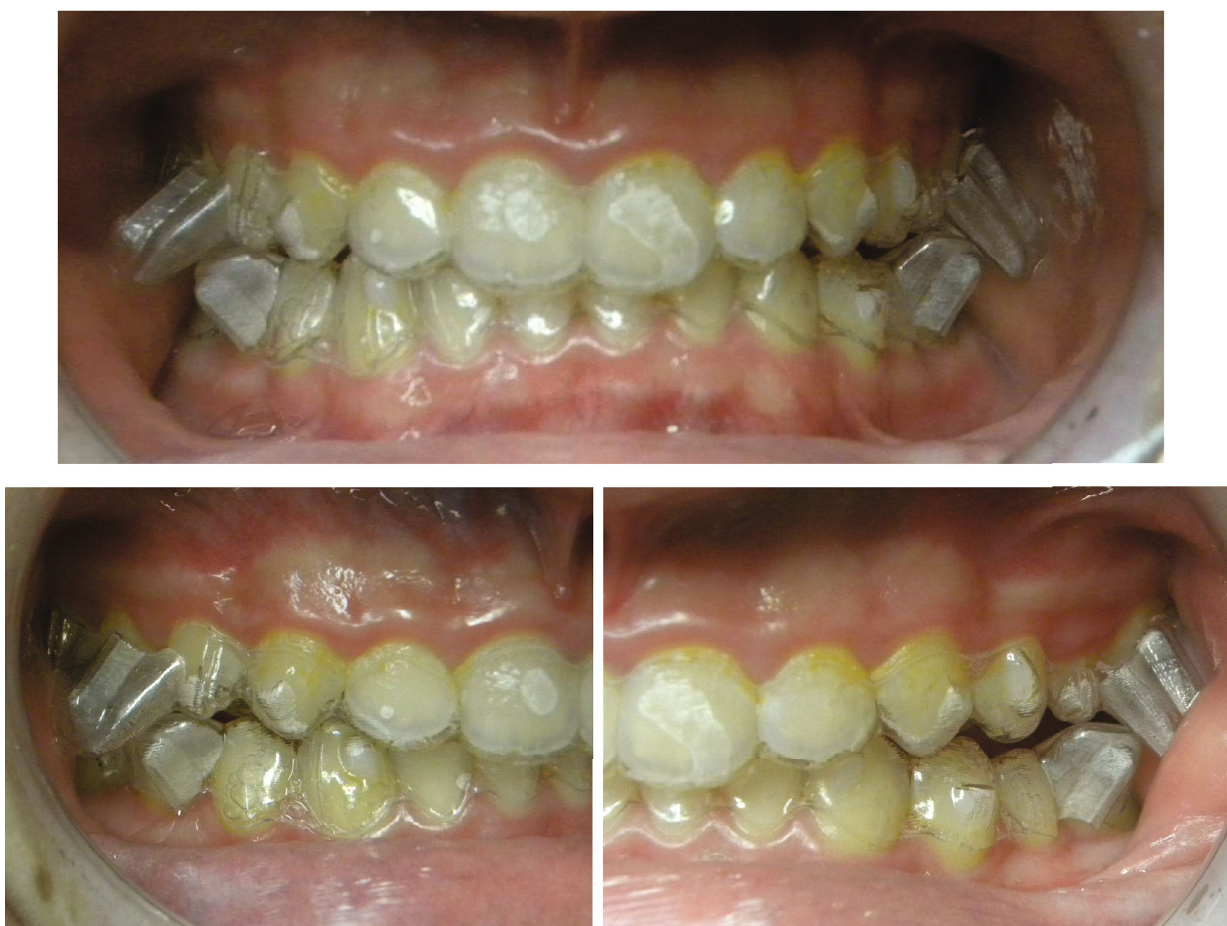
Figure 5: Photographs with IMAF in